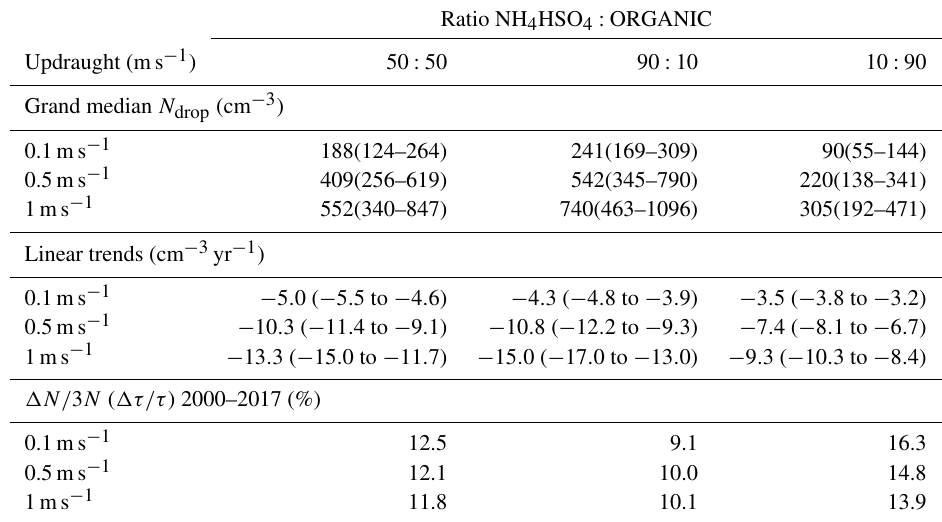
Table 5. Median (and 25th–75th percentile) range (cm − 3 ) of calculated CCNs for different updraught and chemical composition scenarios. See text for details. In the calculation of (cid:49)N/ 3 N the year 2000 has been used as the reference year. Value used is the intercept at the year 2000 of the fitted line. (cid:49)N is calculated as the Theil–Sen slope multiplied with 18 years.